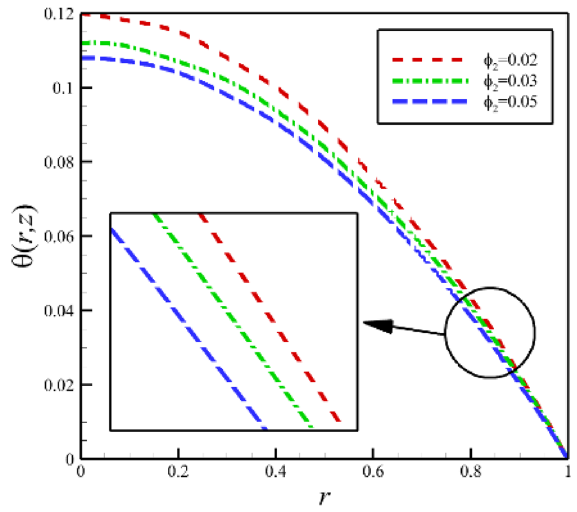
Fig. 11 The influence of variation Al